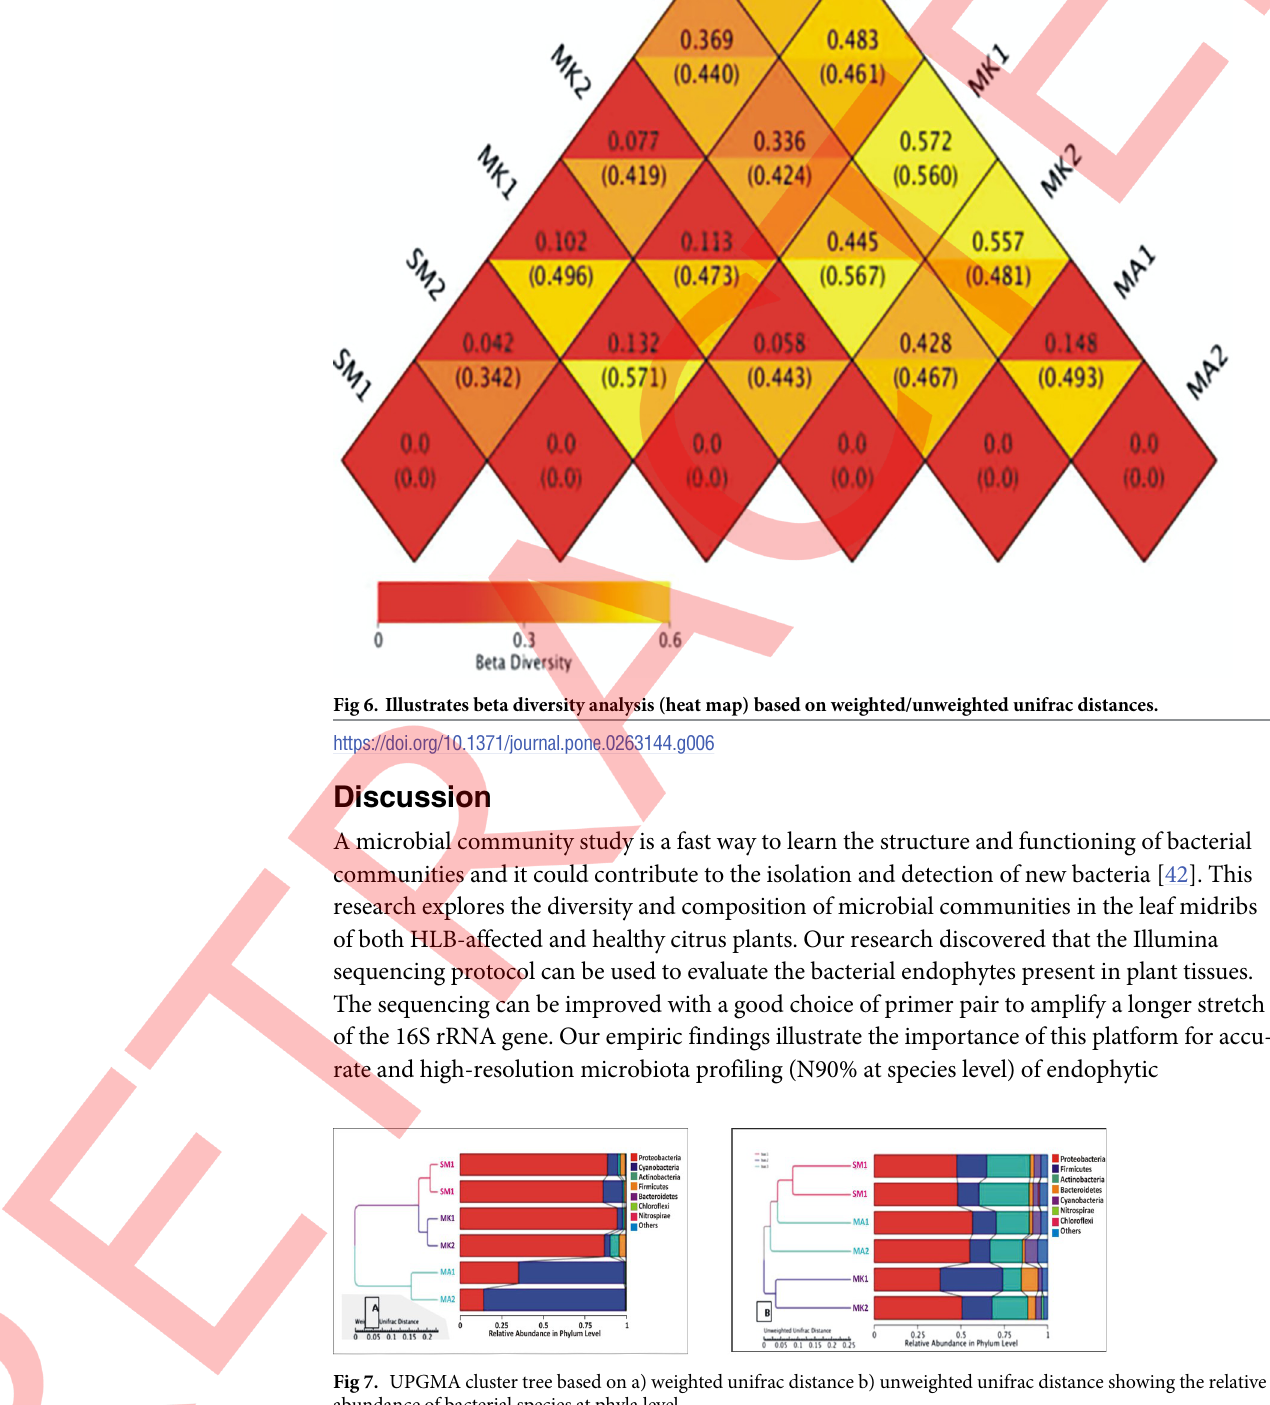
Fig 7. UPGMA cluster tree based on a) weighted unifrac distance b) unweighted unifrac distance showing the relative abundance of bacterial species at phyla